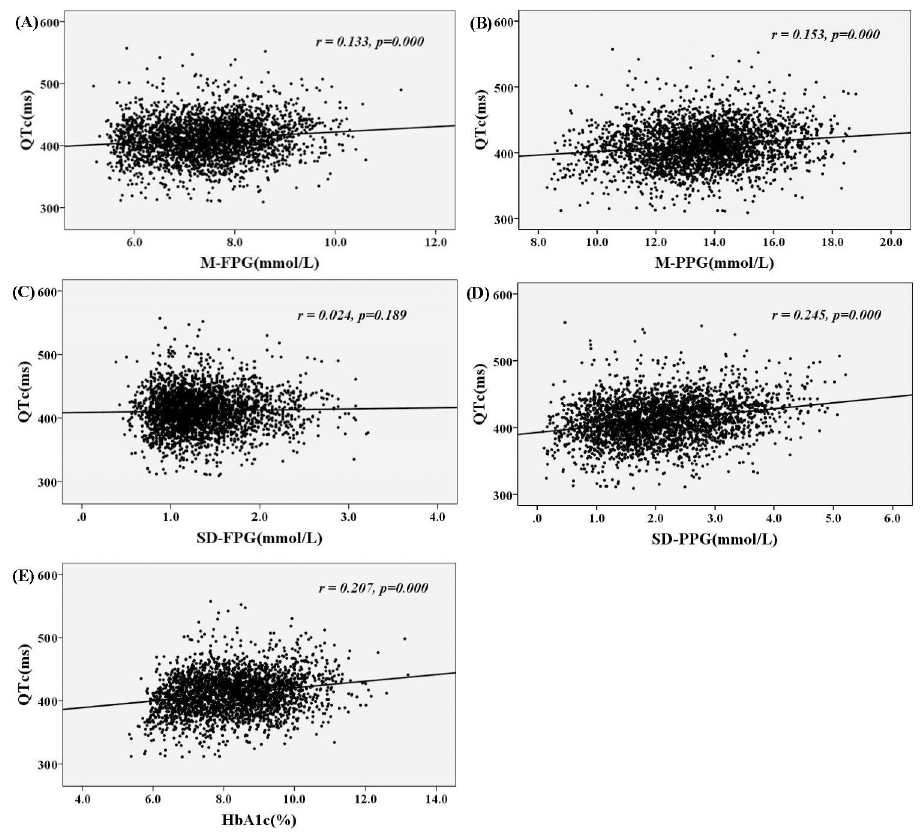
Fig 1. The relationships among glycaemic parameters (A: M-FPG, B: M-PPG, C: SD-FPG, D: SD-PPG, E: HbA1c) and QTc interval in the participants.